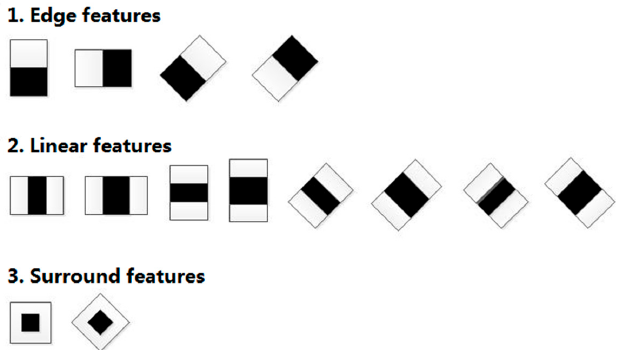
Figure 2. Improved Haar-like feature operators.